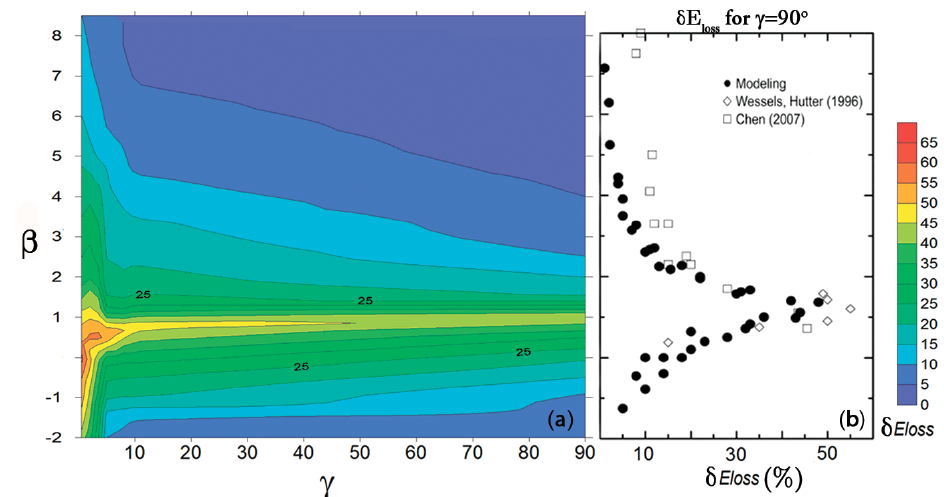
Figure 6. (a) Energy loss ( δE loss ) from internal waves breaking on slopes for γ values from 0.5 to 90 ◦ . (b) The limiting case, γ = 90 ◦ , corresponds to the numerical experiments by Talipova et al. (2013) and the results of laboratory experiments by Wessels and Hutter (1996) and Chen (2007) with steep obstacles.